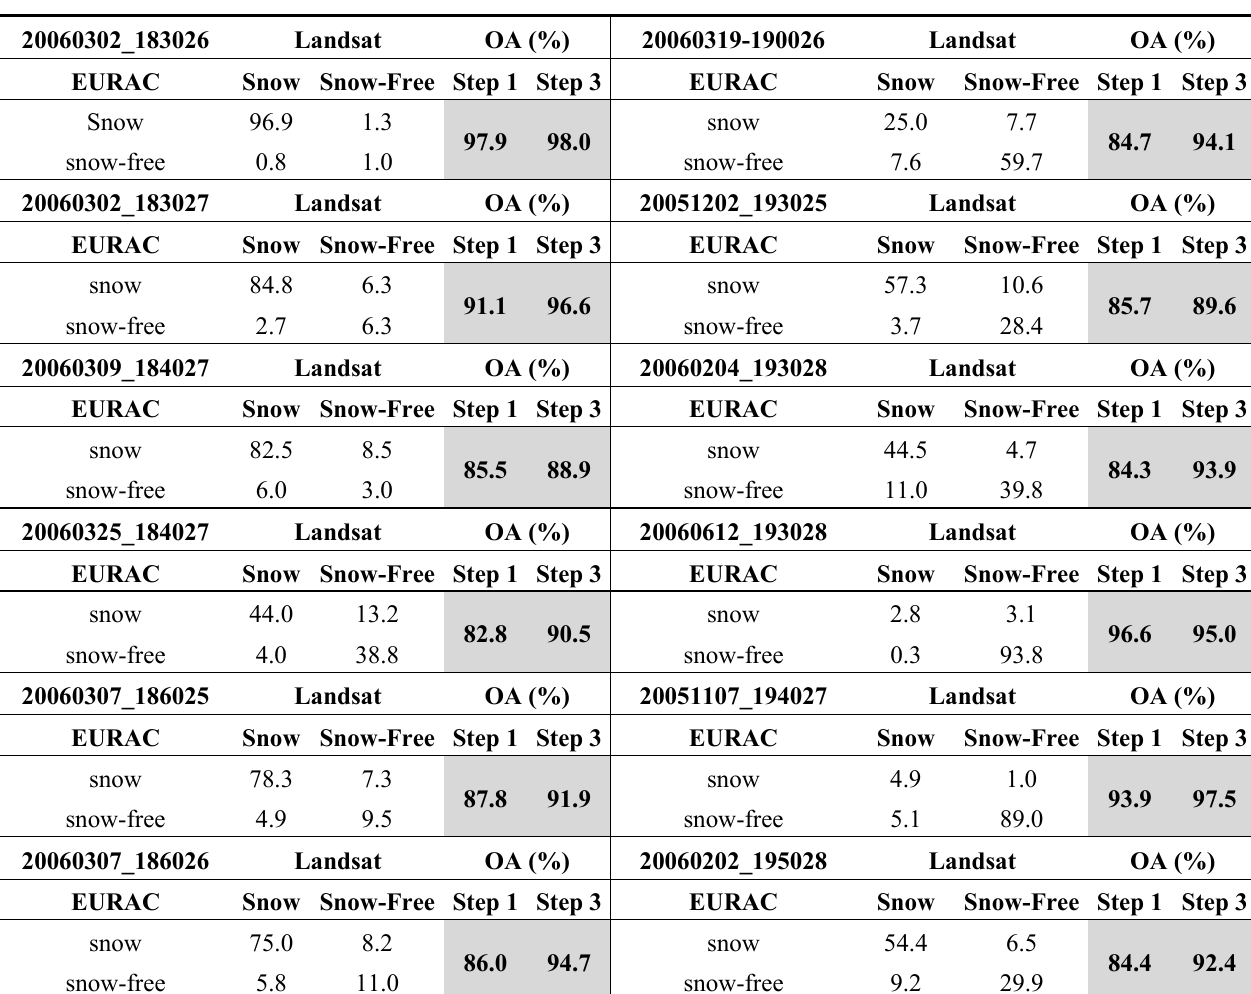
Table 2. Confusion matrix of the EURAC snow cover maps (SCA) maps comparison with sixteen Landsat SCA maps, indicated by their “date_pathrow” (e.g., 20060302_183026, indicating an acquisition on 2 March 2006, with path 183 and row 26). Path and row are used to identify the regions of the globe where Landsat scenes are acquired. In this table, only results from steps 1 and 3 are reported, because step 2 did not bring relevant changes in the accuracy